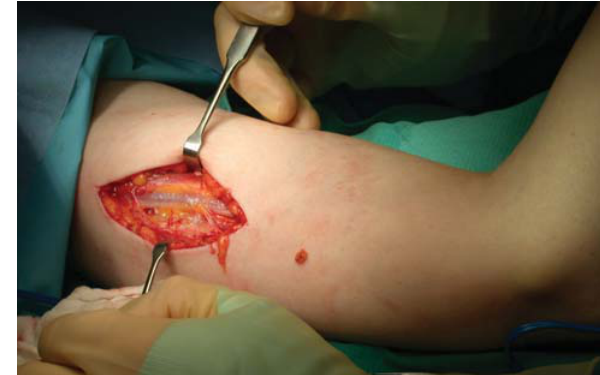
Fig. 3 Longitudinal incision along the medial bicipital groove. Subcutaneous tissue is retracted exposing the underlying medial brachial fascial